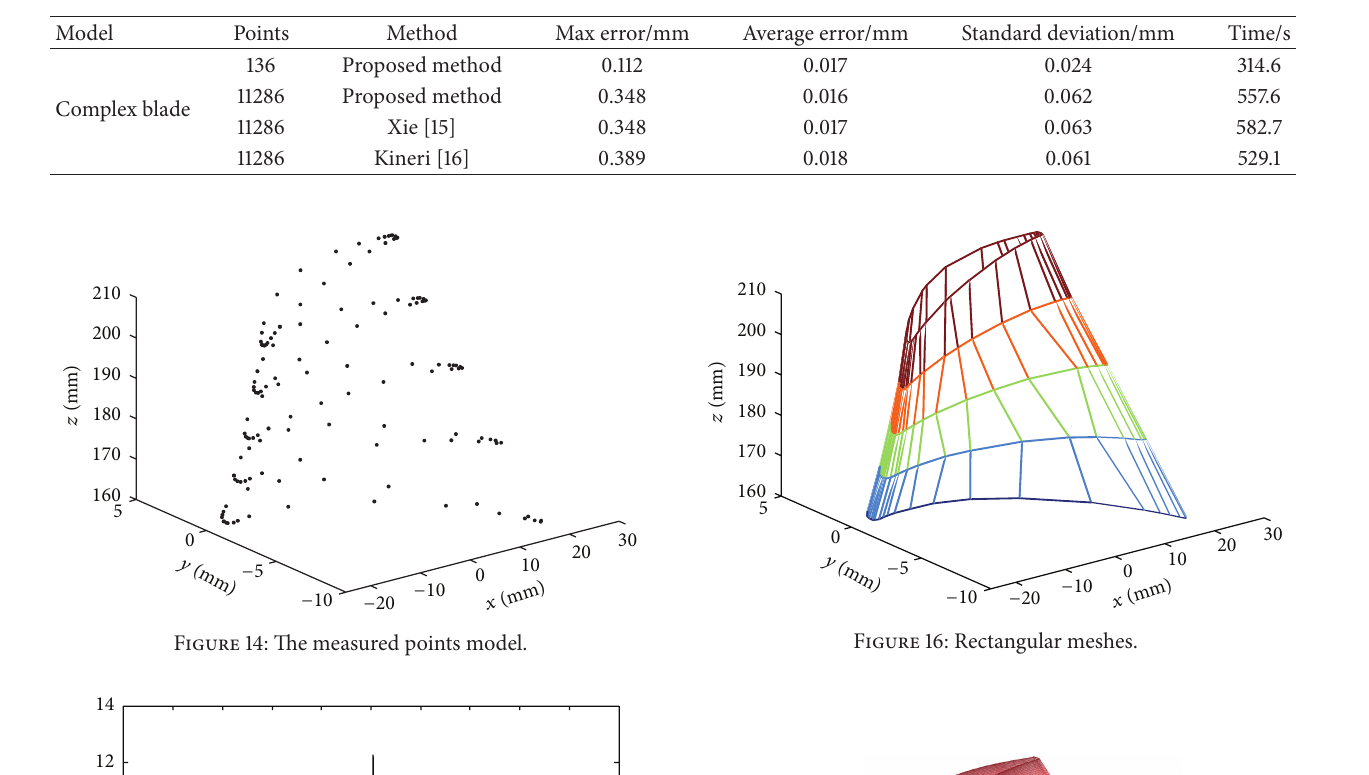
Table 2: Comparison results of multialgorithms for complex blade.